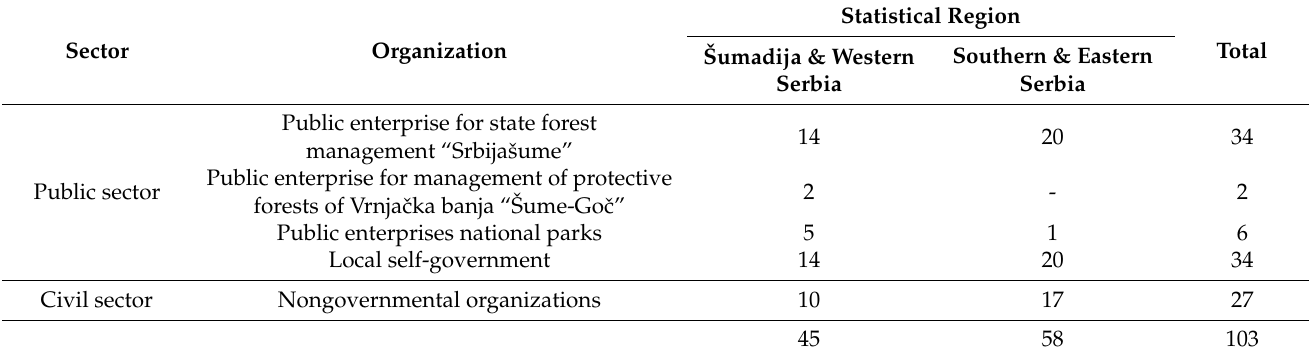
Table 1. Structure of the respondents by sector, organization and statistical region.